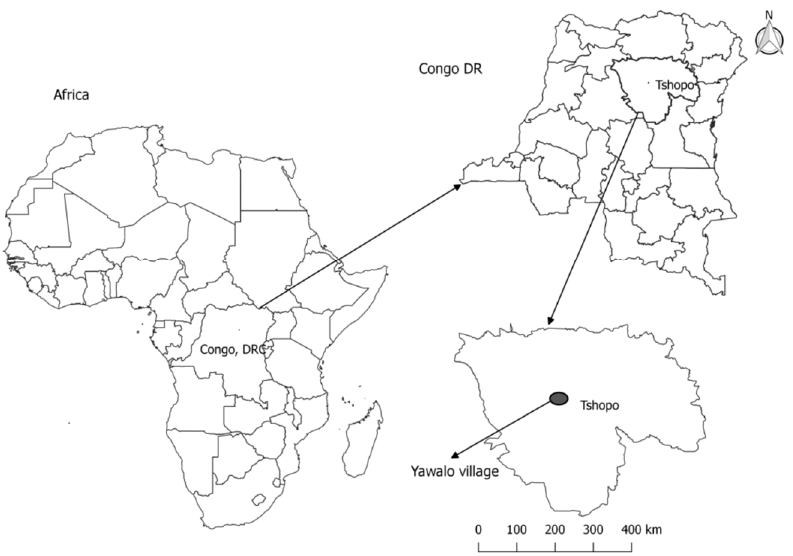
Figure 1. Location of Yawalo Village in Tshopo Province (Democratic Republic of Congo).